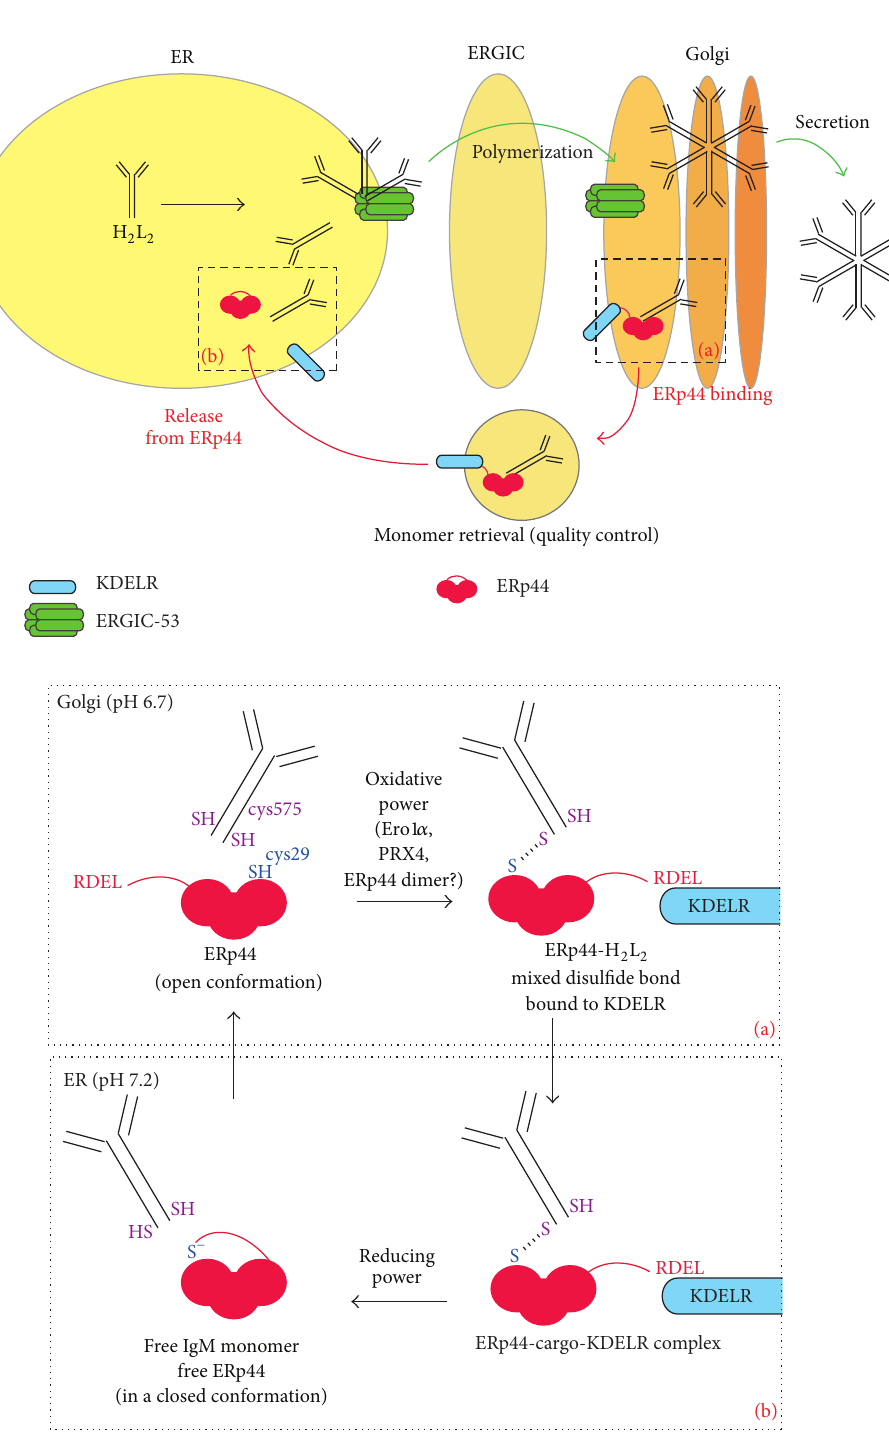
Figure 3: ERp44 quality control and IgM polymerization. IgM monomers are assembled into polymers in the early secretory pathway with the help of the hexameric lectin ERGIC-53. IgM polymers are released from ERGIC-53 in the Golgi and can then be secreted. In the Golgi, ERp44—in an open conformation thanks to the slightly acidic pH—interacts with unassembled IgM subunits exposing the